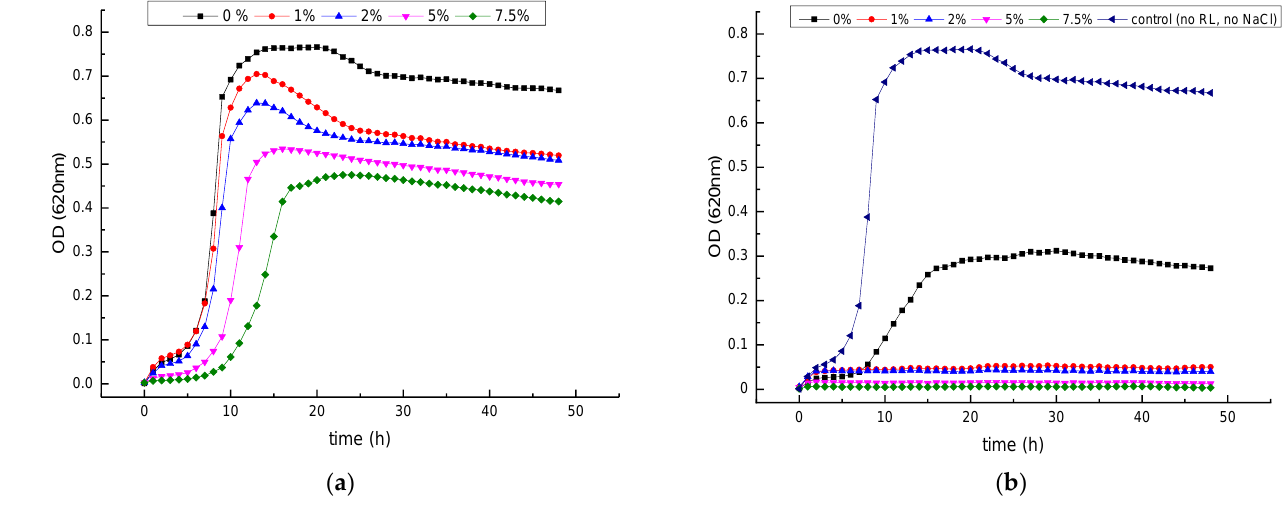
Figure 5. Growth kinetics of L. monocytogenes Scott A in BHI medium supplemented with ( a ) different concentrations of KCl, without RL and ( b ) in combination with 500 µg/mL of RL at 30 °C. Data points represent the mean values of three replicates. Error bars have been omitted for clarity.